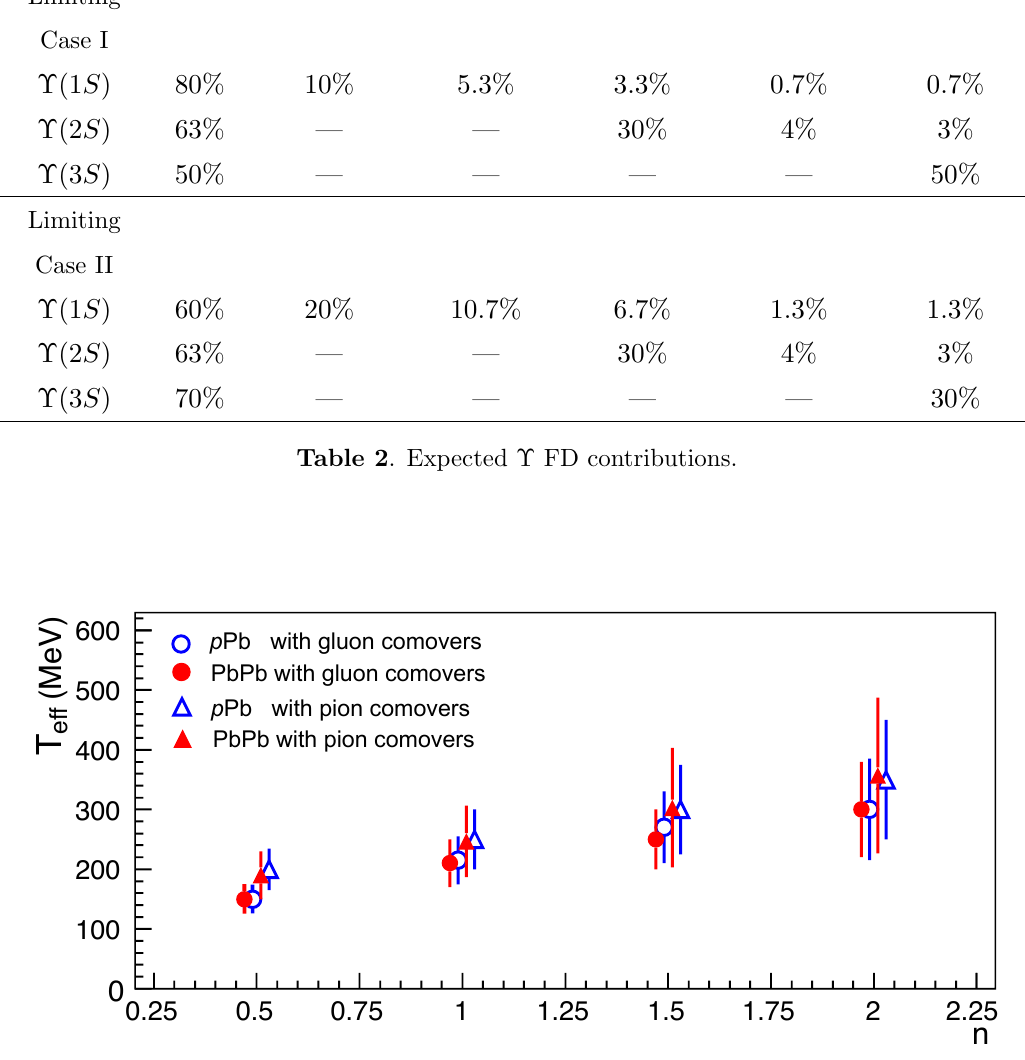
Figure 1 . Resulting T e(cid:11) for pion (triangles) or gluon (circles) comovers from our (cid:12)ts to p Pb (empty blue) and PbPb ((cid:12)lled red) data for di(cid:11)erent n from 0.5 to 2. [The points have been horizontally shifted for